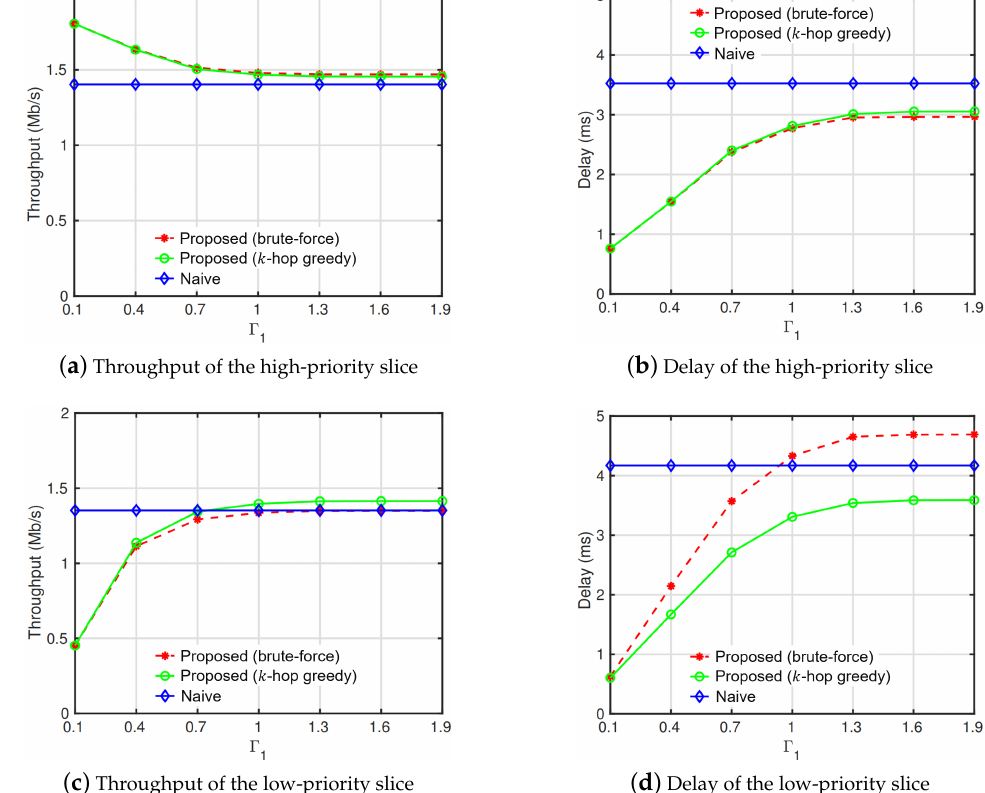
Figure 4. Throughput and delay by the interference threshold of the high-priority slice ( Γ 1